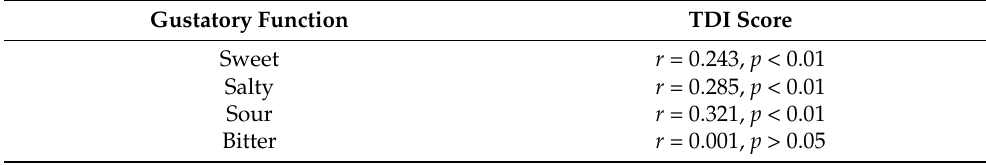
Table 3. Pearson’s correlations between TDI score versus gustatory function in all subjects. Gustatory Function